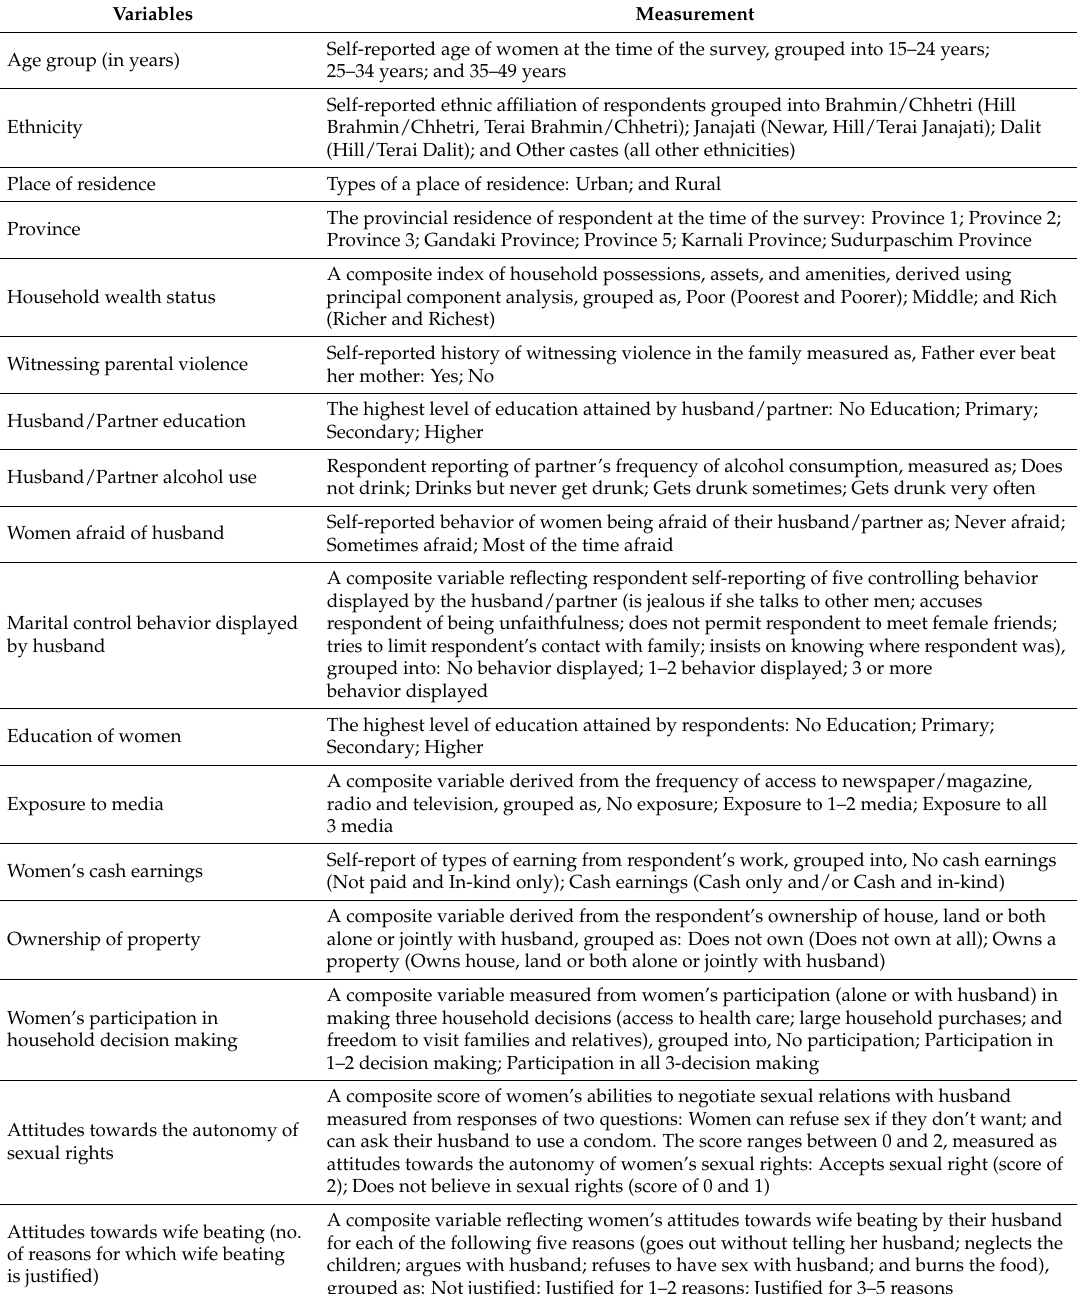
Table 2. Measurement of explanatory